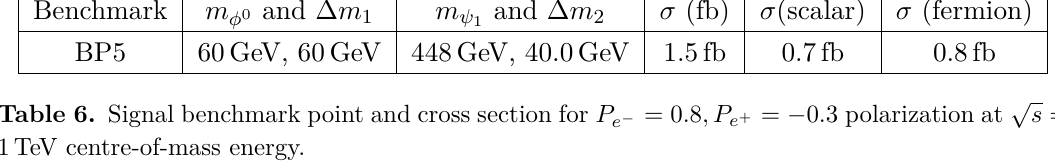
Table 6. Signal benchmark point and cross section for P 1 TeV centre-of-mass energy.